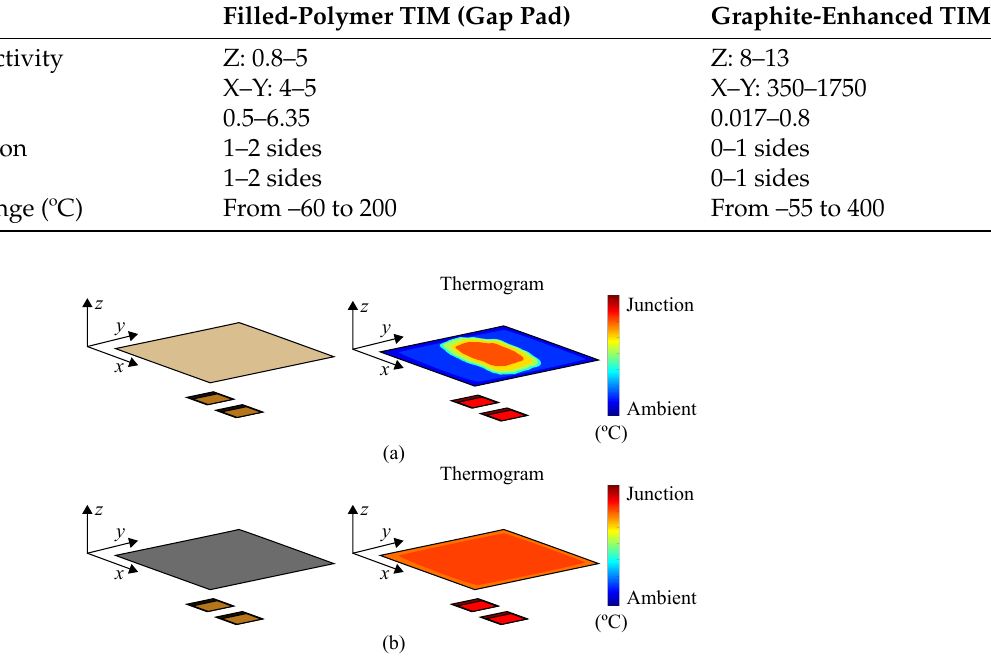
Table 2. Properties of common thermal interface materials [58,63].